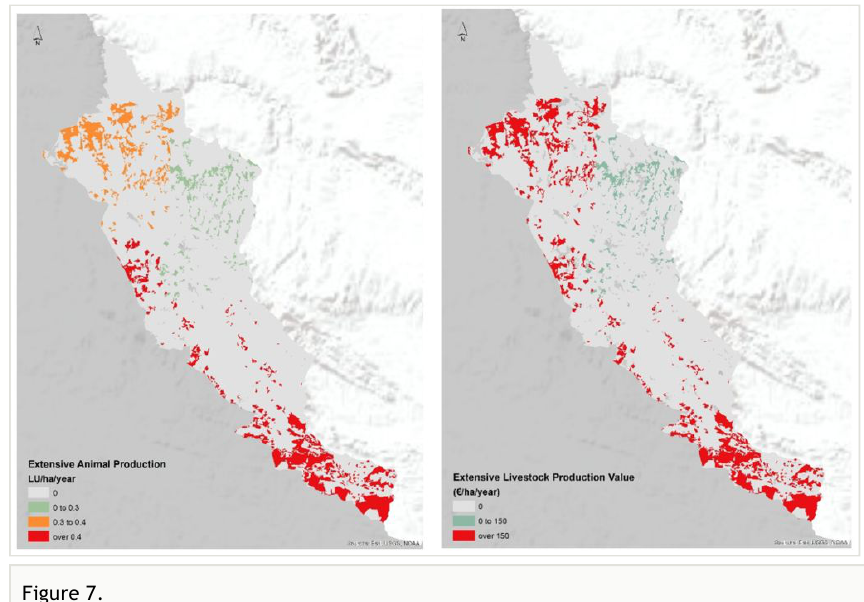
Figure 7. Spatial quanti fi cation (left) and economic valuation (right) of Extensive Animal Production service [ 1.1.3.1 ] within PNSSM.